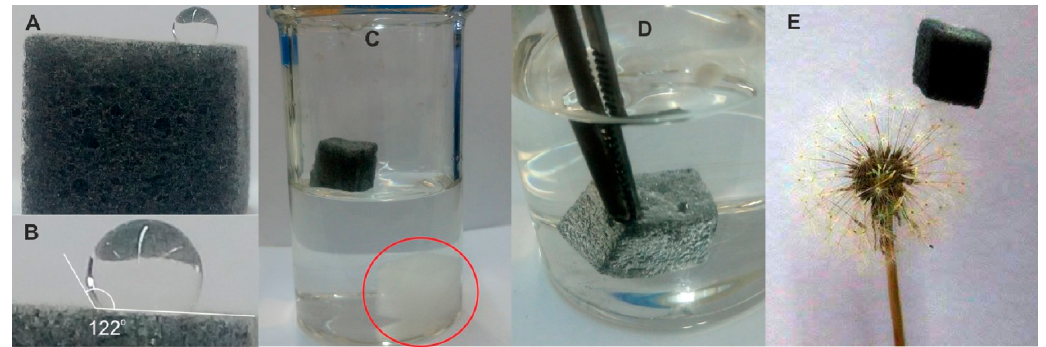
Figure 5. Images of ( A ) water droplet on the surface of a GMeS; ( B ) contact angle of a water droplet; ( C ) MeS and GMes in a glass beaker with water; ( D ) GMeS immersed in water; ( E ) GMeS on top of a dandelion flower. Source: Reproduced from [10], with permission from Elsevier .